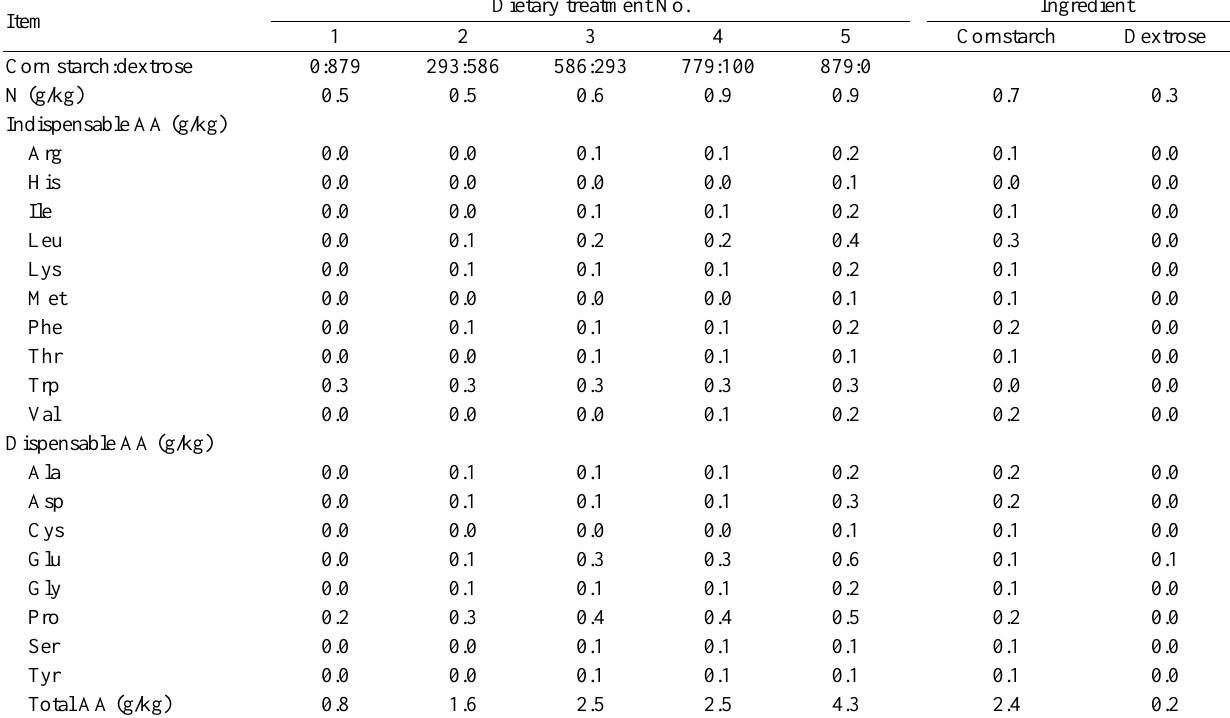
Table 2. Analyzed AA, and CP composition of the experimental diets and ingredients, as-fed basis Dietary treatment No. Item